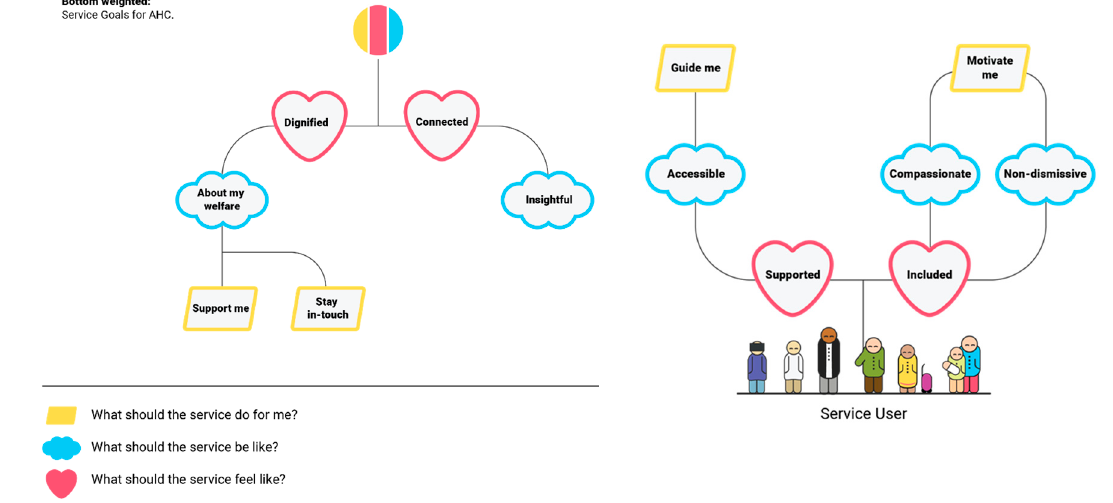
Figure 2. Goals (do/be/feel) that a social prescribing service should do according to the community. A final co-design workshop with staff confirmed the values and goals collected with the service recipients. This led to a service concept based on the goals and values of the